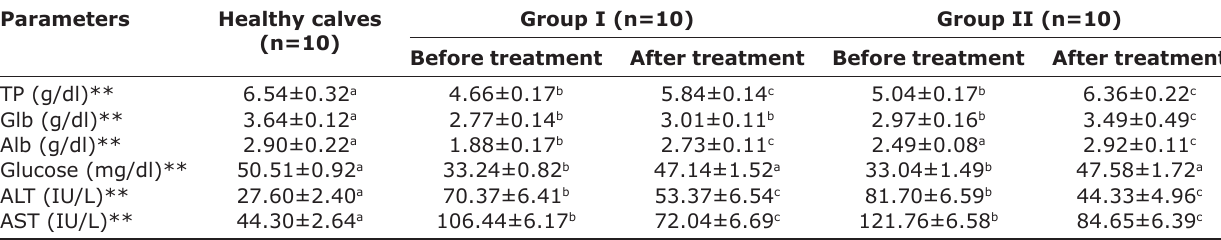
Table-3: Mean±SE values of biochemical parameters in apparently healthy and bovine tropical theileriosis infected calves (before and after treatment).